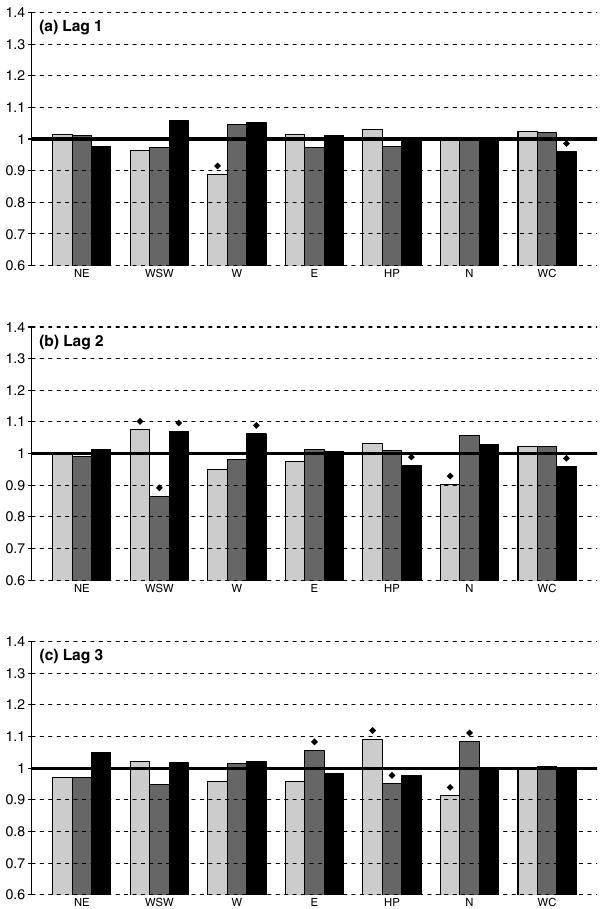
Figure 6. Ratios of the frequency for the low (light grey), mod- erate (grey), and high (black) solar activity classes for 1-year (a) , 2-year (b) , and 3-year (c) lags relative to the long-term mean. Dots correspond to statistical significance of the ratios at the 95%